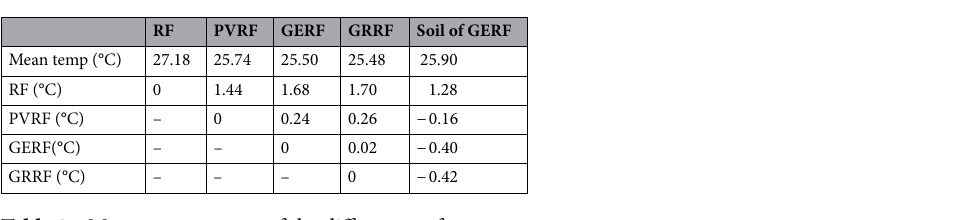
Table 8. Mean temperatures of the different